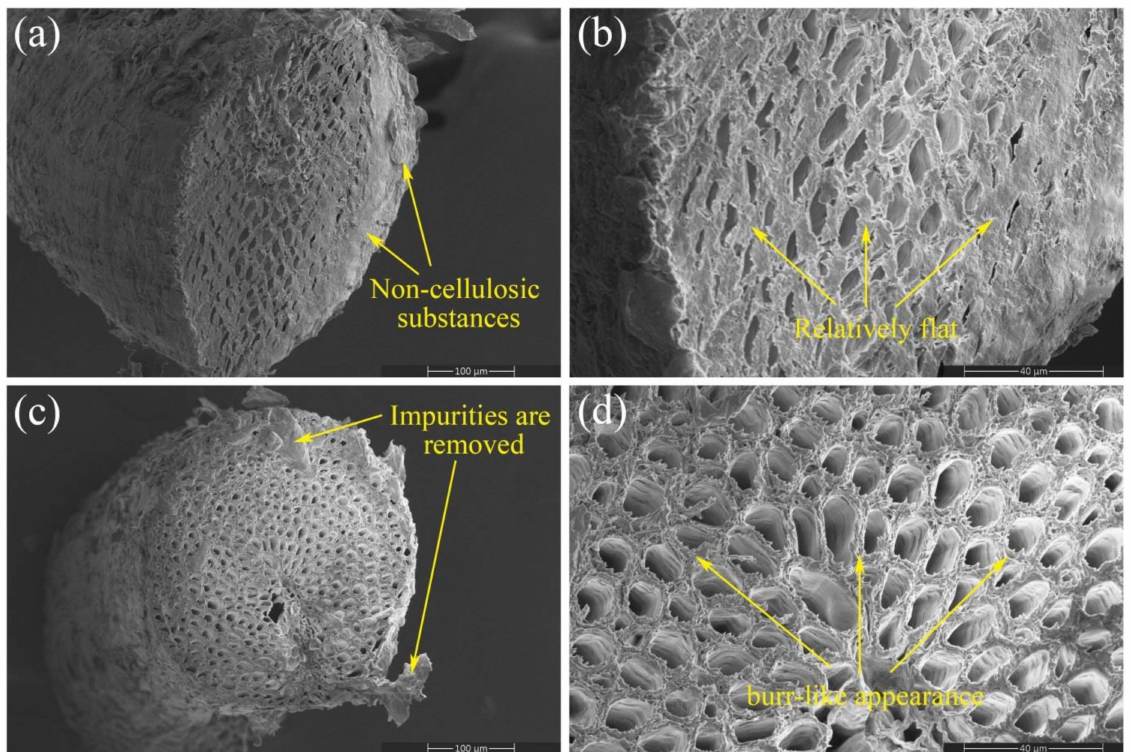
Figure 11. SEM micrographs of coir fiber cross-sections: ( a ) untreated fiber (200 × ), ( b ) untreated fiber (800 × ), ( c ) treated fiber under optimal conditions (200 × ) and ( d ) treated fiber under optimal conditions (800 ×